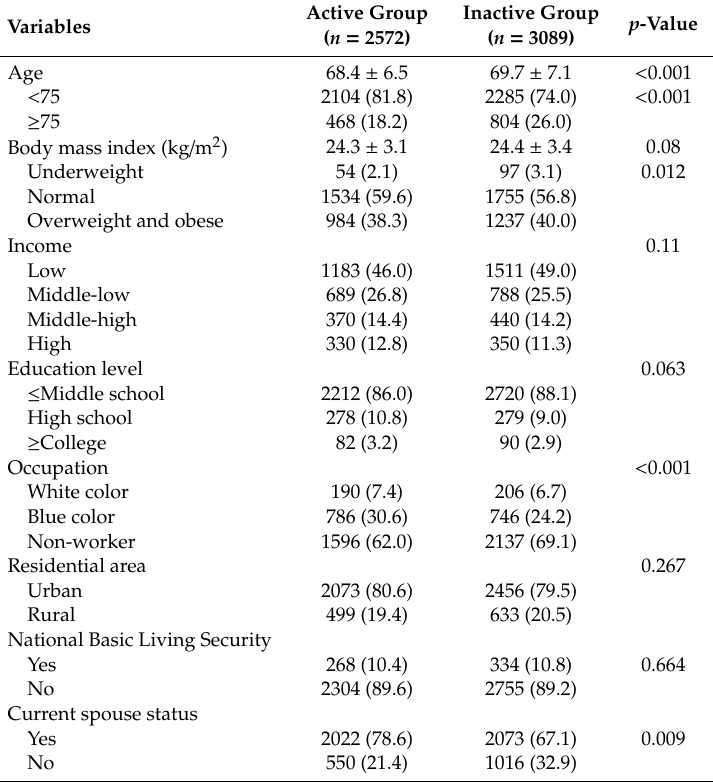
Table 1. General characteristics according to physical activity.